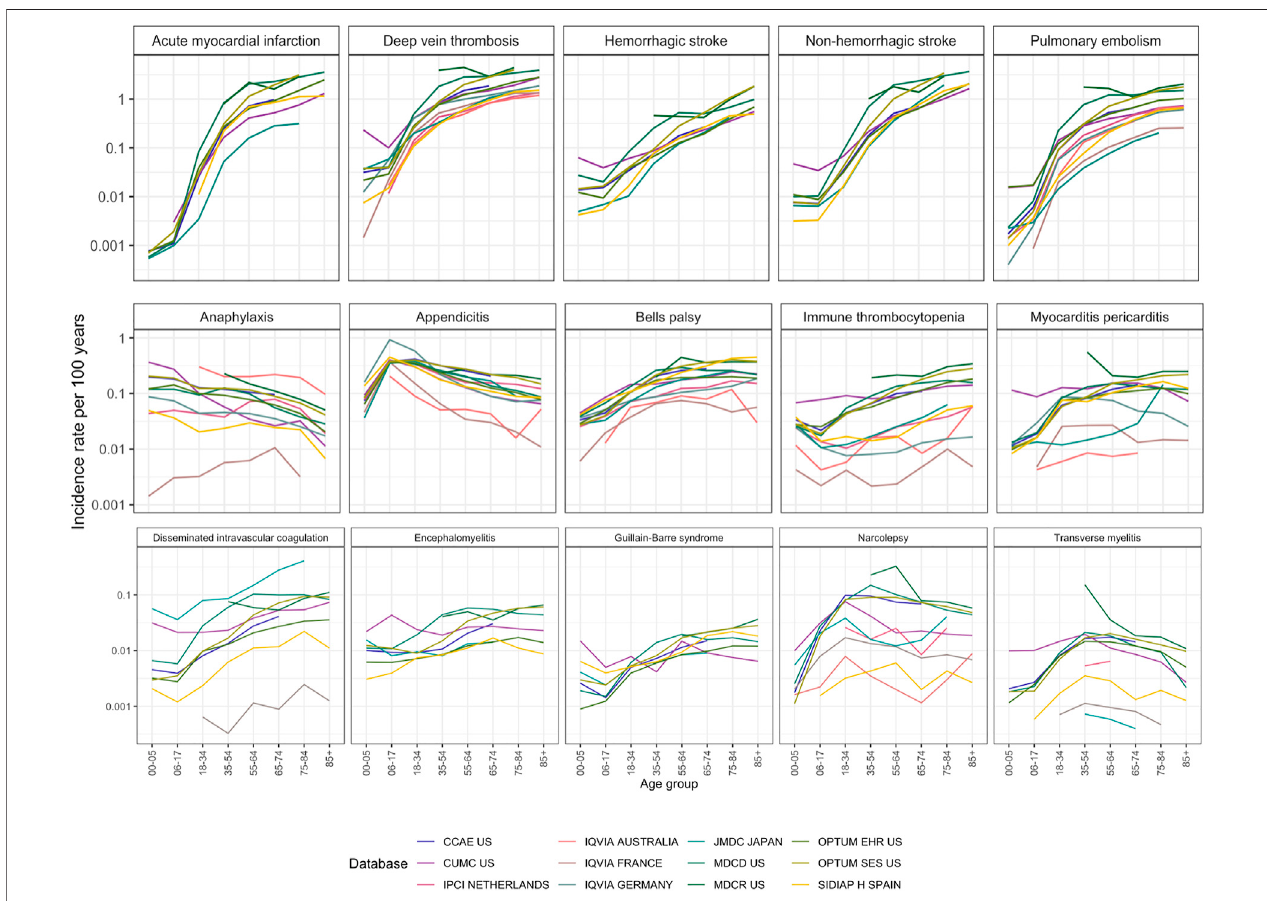
FIGURE 3 | Incidence rates in age groups in 2017 – 2019 in patients entering on January 1 with a 365 days time-at-risk and 365 days of pre-entry observation period. Outcomes were arranged by maximum incidence per age stratum from the most common to the least common.